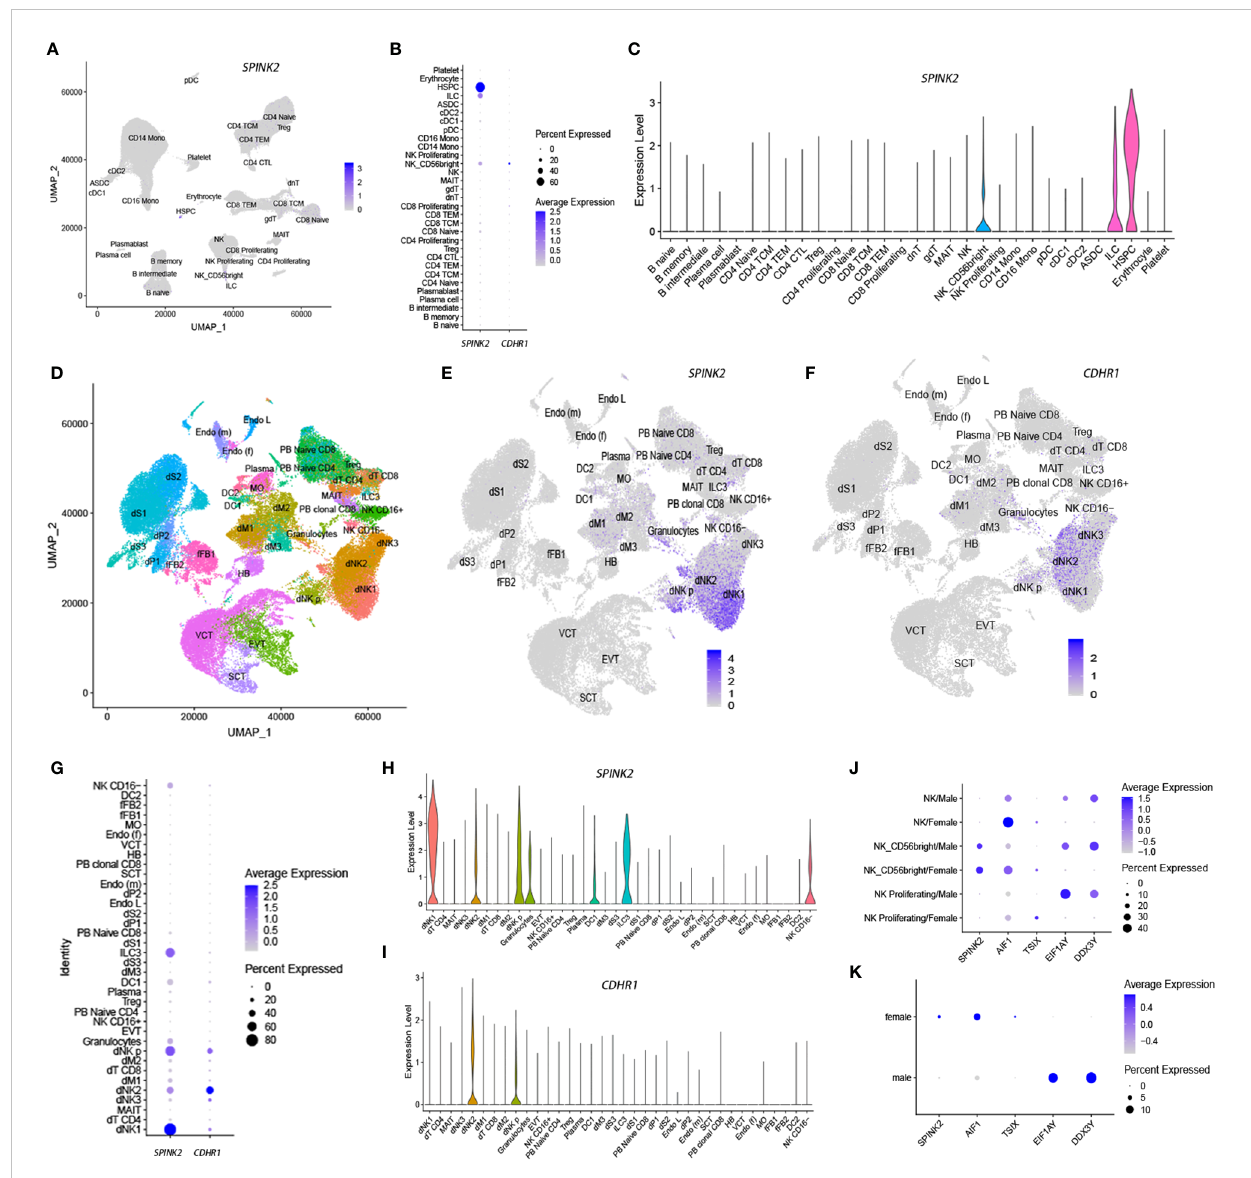
FIGURE 8 SPINK2 and CDHR1 single-positive NK cells are enriched in the decidua based on single-cell transcriptomic analysis. The indicated gene expression levels are illustrated by feature plots (A, E, F) , dot plots (B, G) and violin plots (C, H, I) in both PBMCs (A – C) and decidua (E – I) . The UMAP plot in (D) shows cell types in the decidua, as well as in peripheral blood (PB) for some cell types. SPINK2 and the correlated gene AIF1 show higher expression in female NKs, as supported by either PBMC (J) or lung cancer (K) datasets. The genes TSIX, EIF1AY and DDX3Y represent positive controls to indicate female (TSIX) and male (EIF1AY, DDX3Y) NKs. Some cell abbreviations are shown as follows. dNK1-3, decidual NK-cell cluster 1-3; dT CD4, decidual CD4 + T cells; MAIT, mucosal-associated invariant T cells; dM1-3, decidual macrophage cluster 1-3; dNK p, decidual proliferative NK cells; EVT, extravillous trophoblast; DC, dendritic cells; dS1-3, decidual stromal cell cluster 1-3; dP1-2, decidual perivascular cell cluster 1-2; Endo L, lymphatic endothelial cells; Endo (m), maternal endothelial cells; SCT, syncytiotrophoblast; HB, Hofbauer cells; VCT, villous cytotrophoblast; Endo (f), fetal endothelial cells; MO, maternal macrophages; fFB1-2, fetal fi broblast cluster